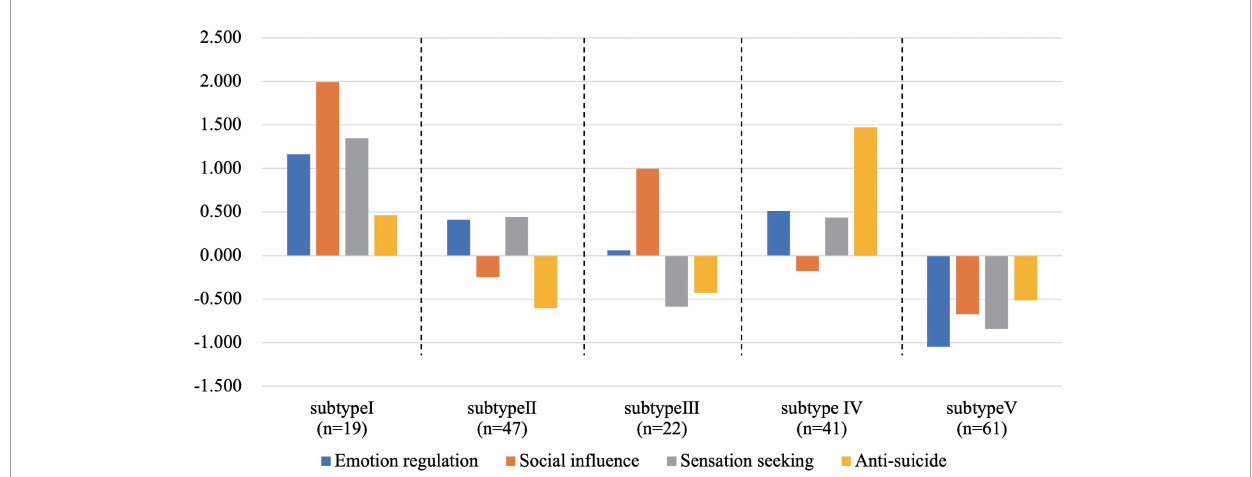
FIGURE3 The functional subtypes of NSSI. All the four standardized score of NSSI function were higher than the average level in the subtype I; all the four standardized score of NSSI function were lower than the average level in the subtype V; the standardized score of “sensation seeking” was obviously higher than the average level compared with other functions in subtype II; the standardized score of “anti-suicide” was obviously higher than the average level compared with other functions in subtype III; the standardized score of “social influence” was obviously higher than the average level compared with other functions in subtype IV.